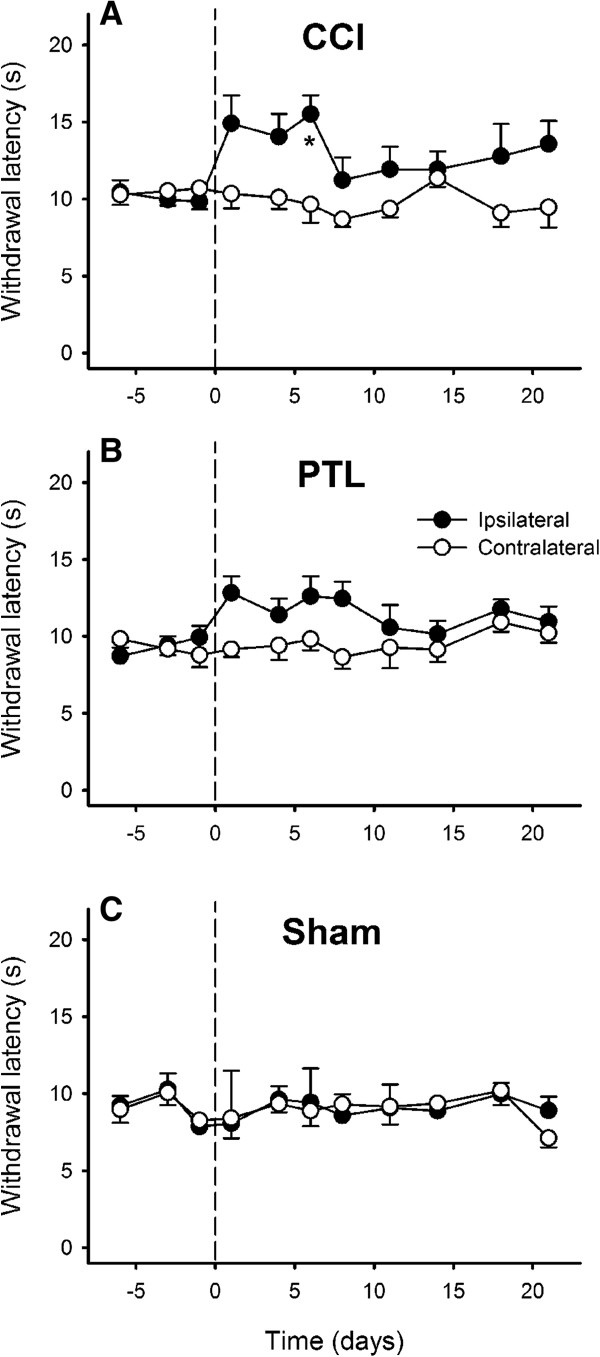
Time course of the development of heat-evoked behaviours after injury of the mental nerve. Withdrawal latencies to radiant heat stimulation of the chin were significantly increased 6 days after chronic constriction injury (CCI) of a mental nerve (A), but not after partial tight ligation of the nerve (PTL; B) or sham operation (C). The operation was performed on day 0 (indicated by the dashed line). Symbols are mean ± 1 S.E.M. Asterisk indicates significant differences between ipsilateral and contralateral sides (P < 0.03; 2-factor repeated measures ANOVA followed by Tukey’s test post-hoc).